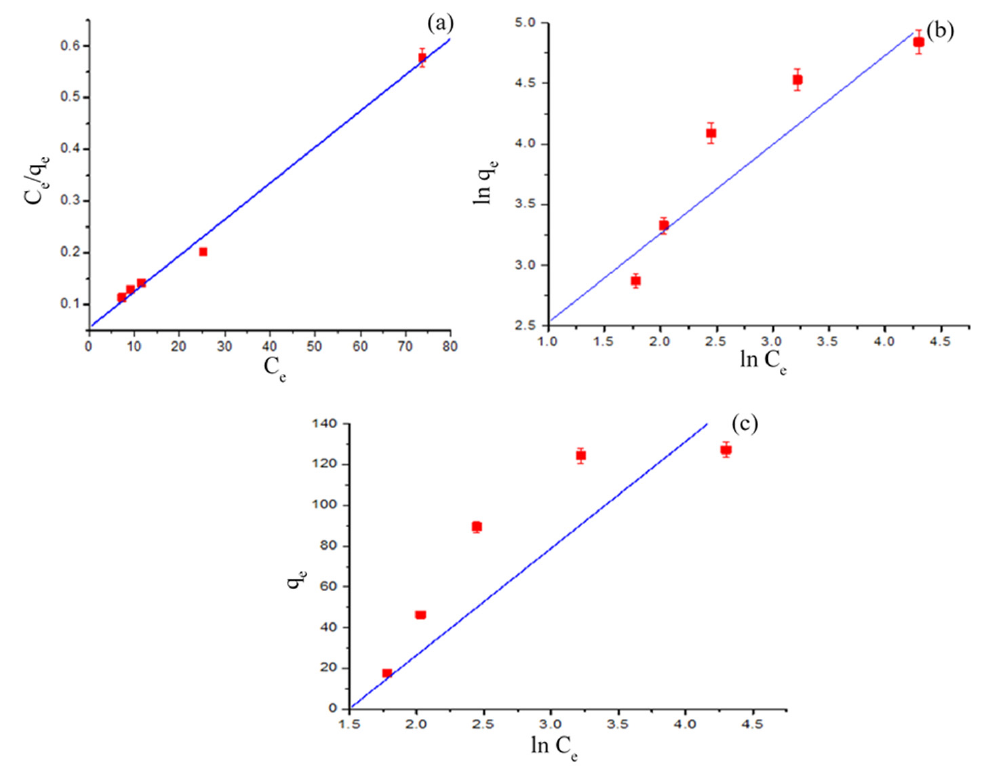
Figure 7. Langmuir ( a ), Freundlich ( b ), and Temkin ( c ) isotherm plots for BG adsorption on GO-PANI.